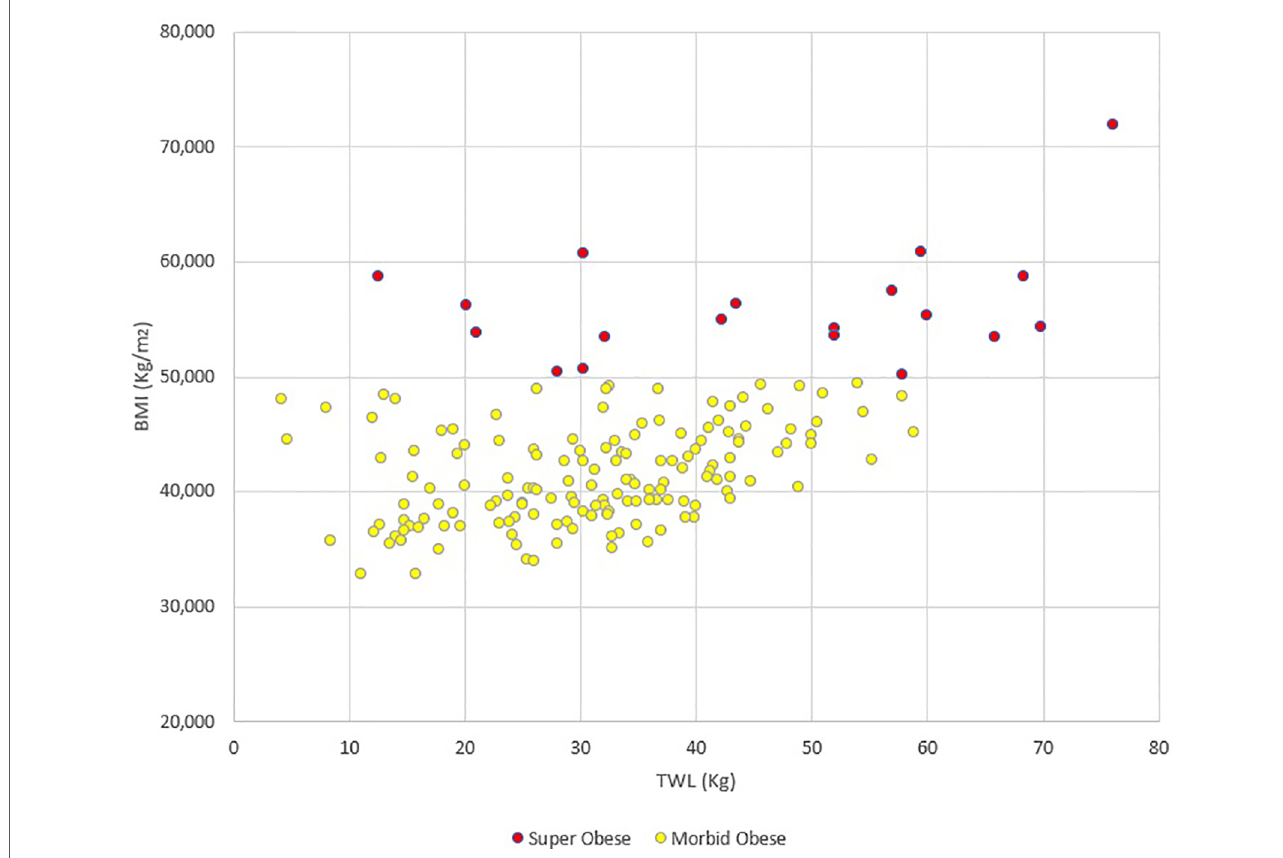
FIGURE 1 Scatter diagram representing the correlation between preoperative BMI and total weight loss (TWL). The correlation test demonstrated that preoperative BMI> 50 Kg/m 2 was signi fi cantly associated with a higher TWL (correlation coef fi cient=0.4914; p